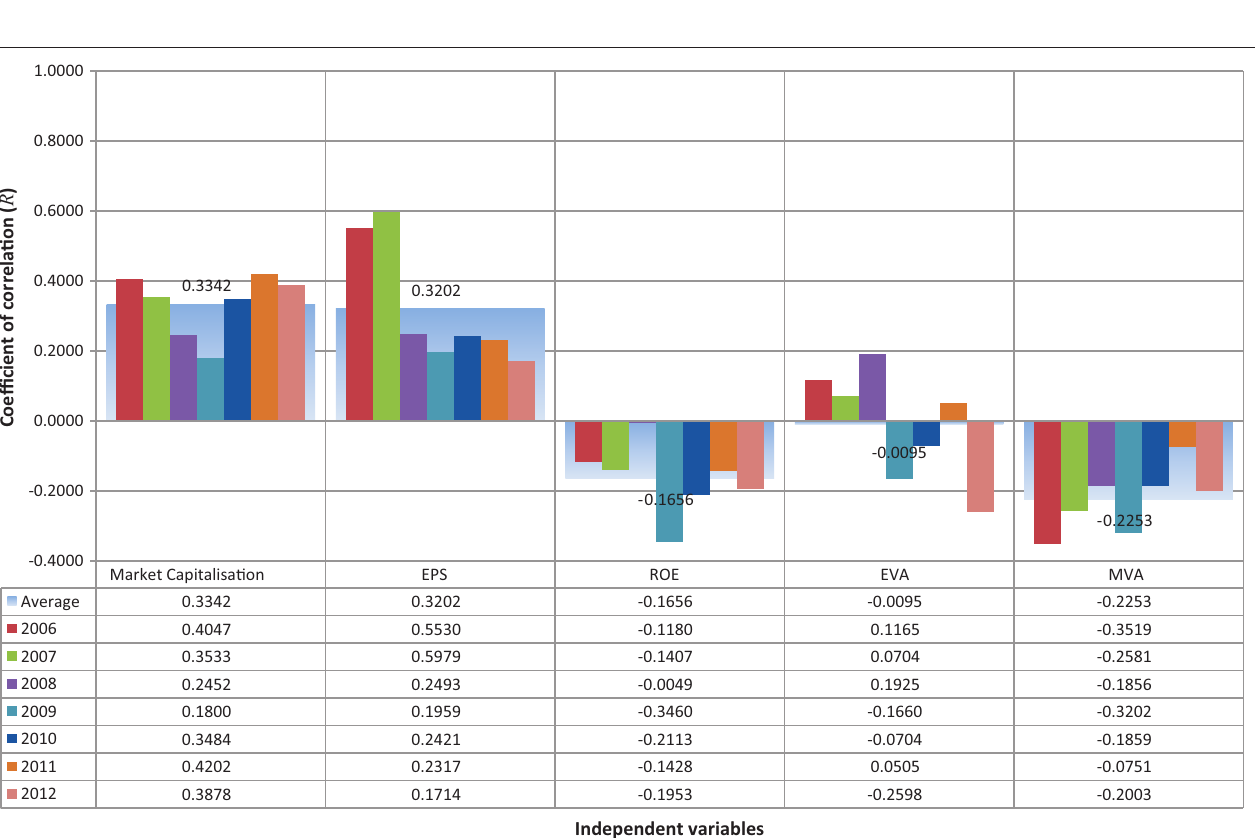
FIGURE 8: Correlation analysis: Short-term incentives and organisational performance